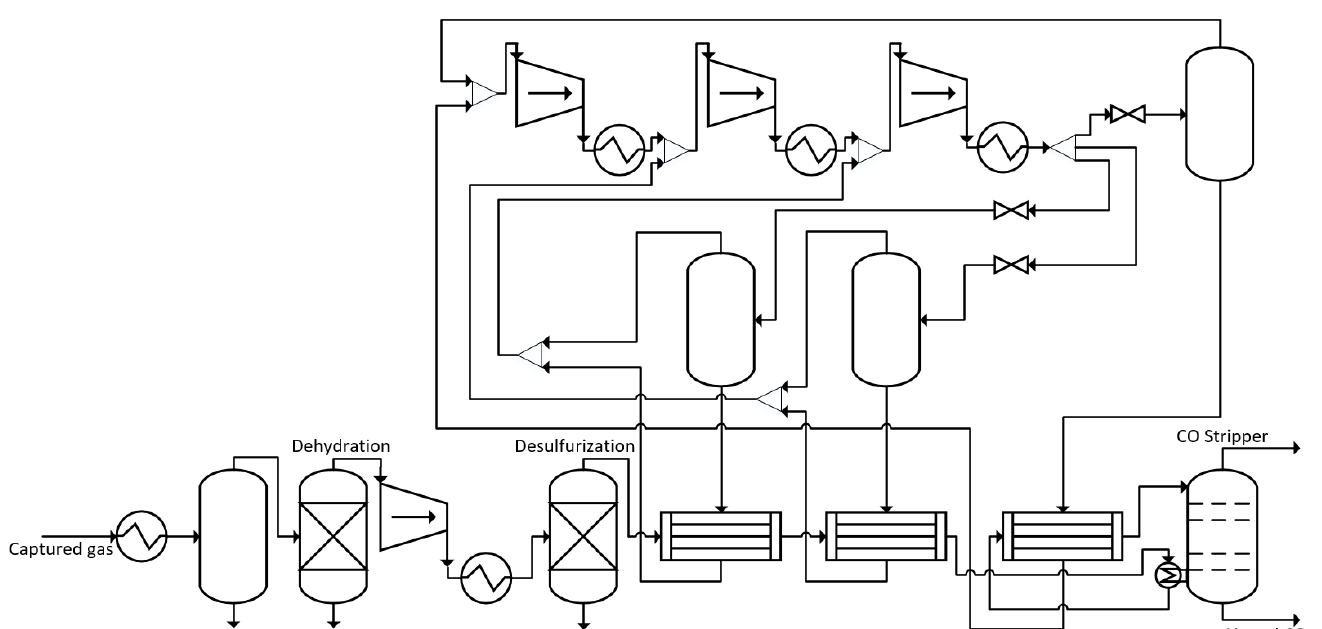
Figure 14. Process flow diagram for the closed-cycle configuration 3.